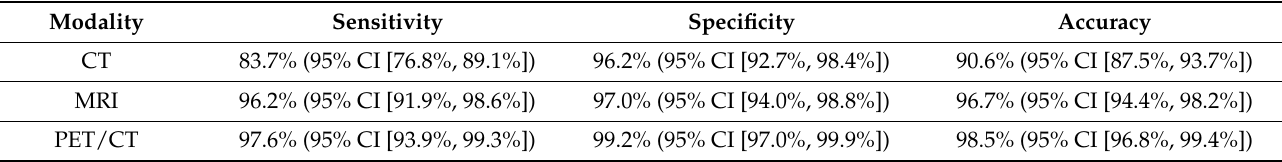
Table 3. Diagnostic performance for the detection of pathological lymph nodes in CT vs. MRI vs. PET/CT.